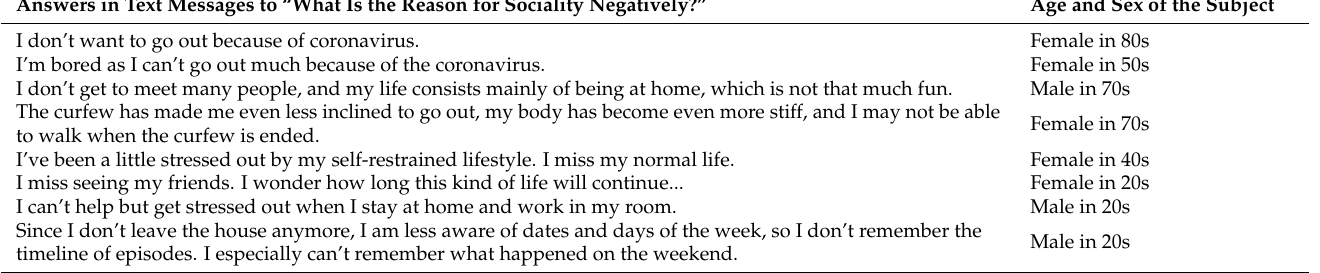
Table 4. Representative further explanations after the negative sociality answered by subjects.